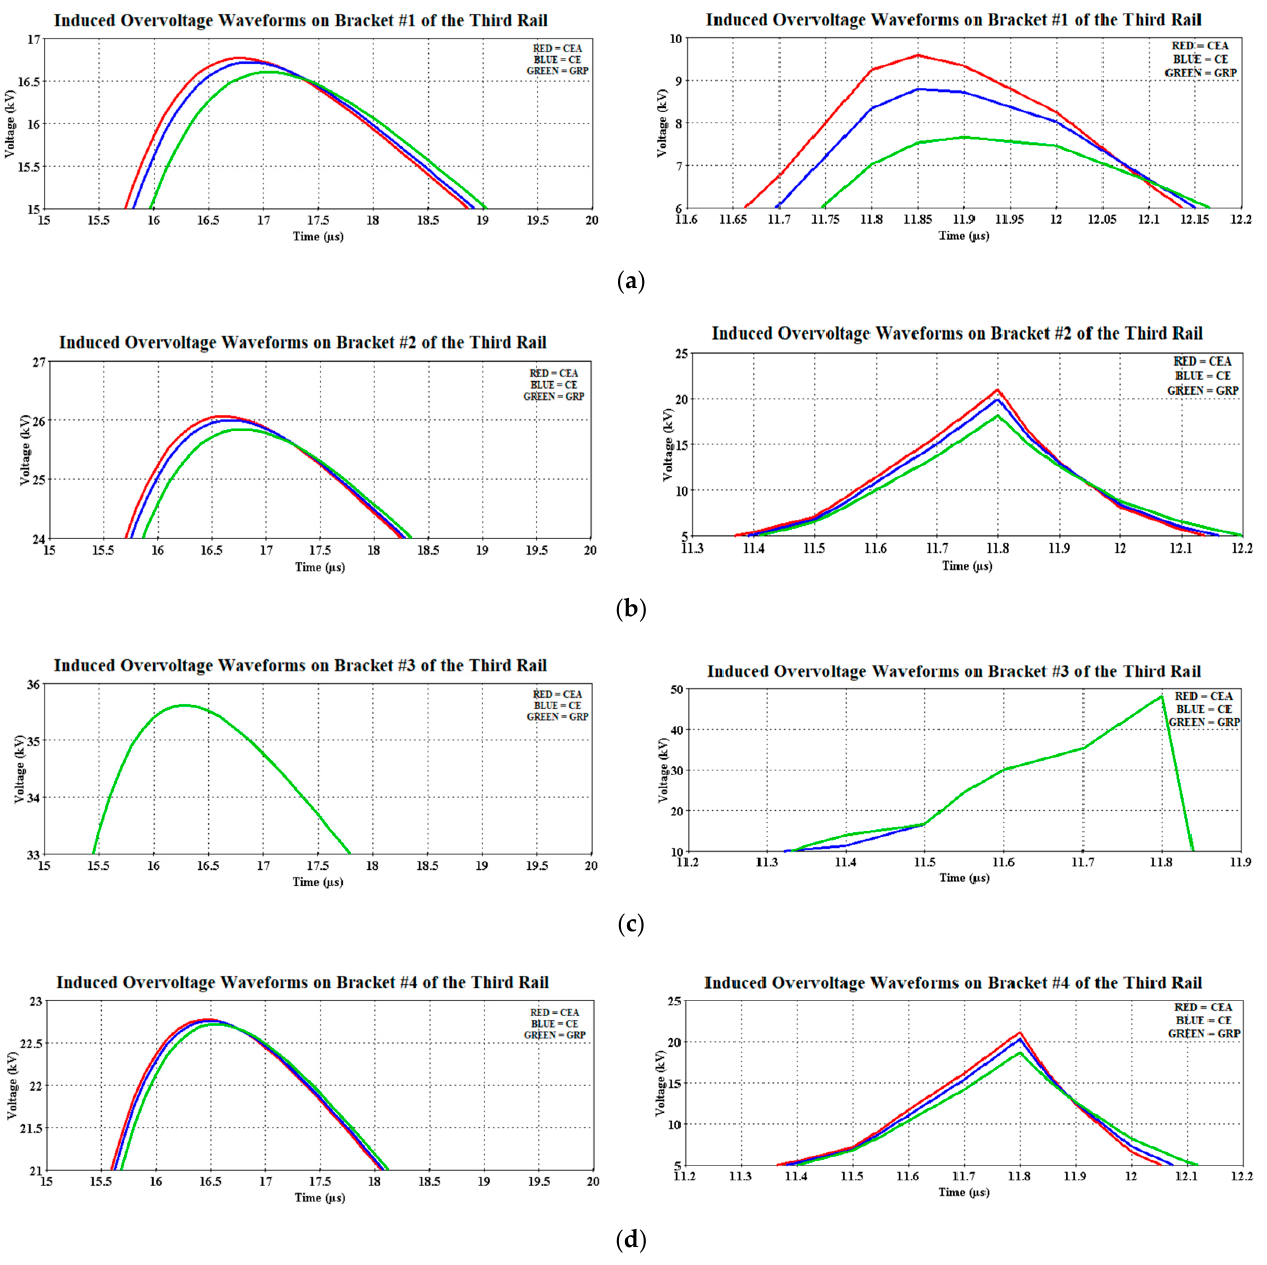
Figure 8. Magnified Figure 7 for a clearer view. ( a ) First bracket, ( b ) second bracket, ( c ) third bracket, and ( d ) fourth bracket for both 30 kA ( left ) and 90 kA ( right ).